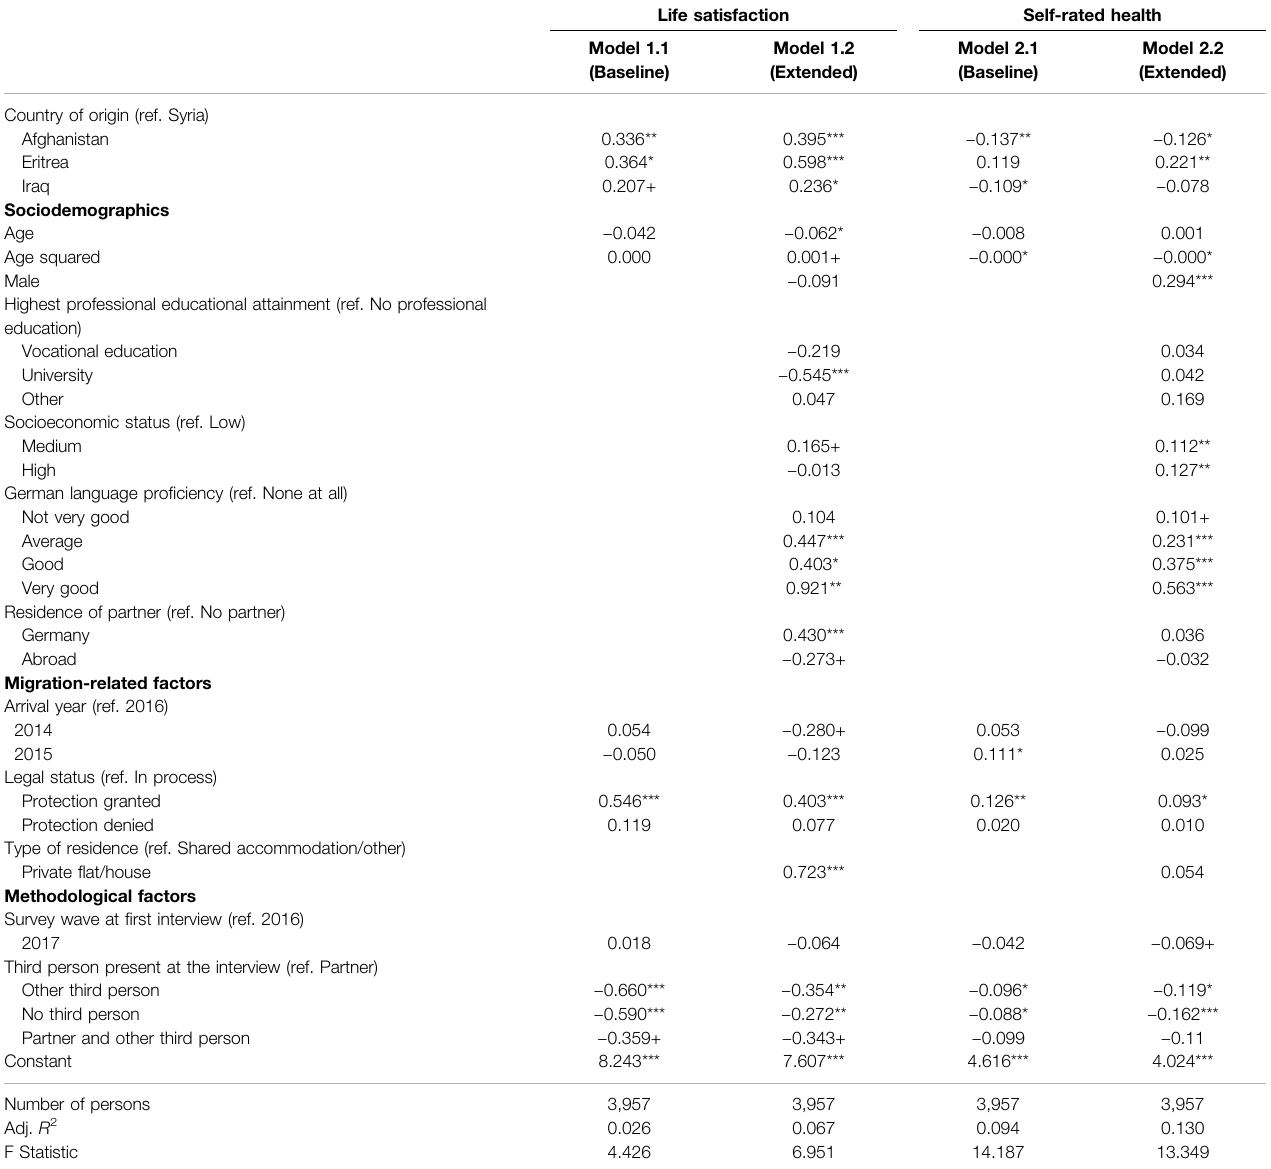
TABLE 1 | Life satisfaction and self-rated health at the fi rst